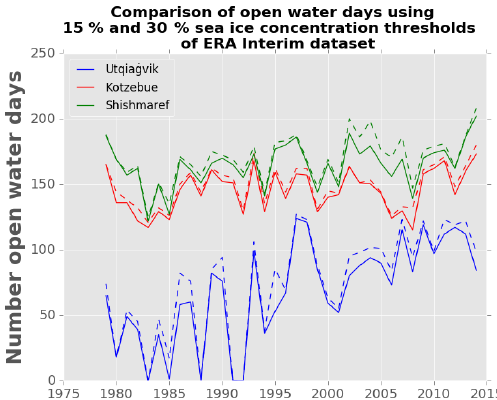
Figure 2. The number of open water days are similar when a 15% (solid line) or 30% (dashed line) sea ice concentration threshold is used. When the sea ice concentration (area of the grid cell) is lower than the threshold value, it is considered open water. Sea ice concentrations for the communities are extracted from the grid cells labeled as “Downscaled ERA” in Fig.